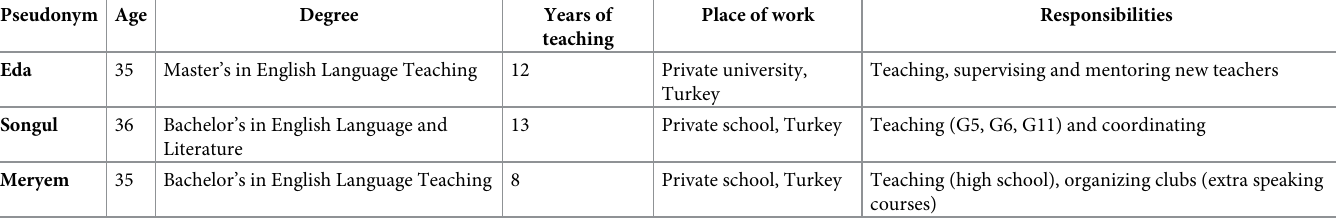
Table 1. Demographic information of